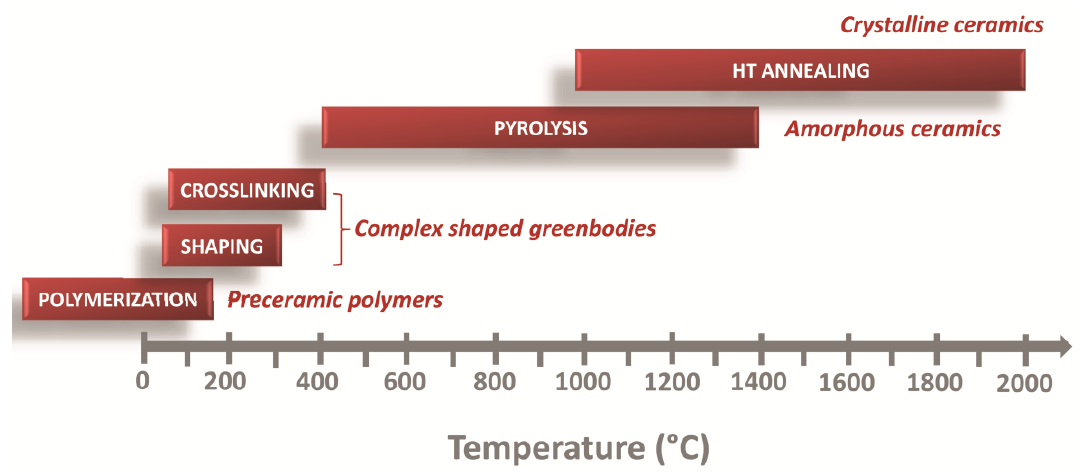
Figure 6. Polymer-to-ceramic transformation of preceramic polymers